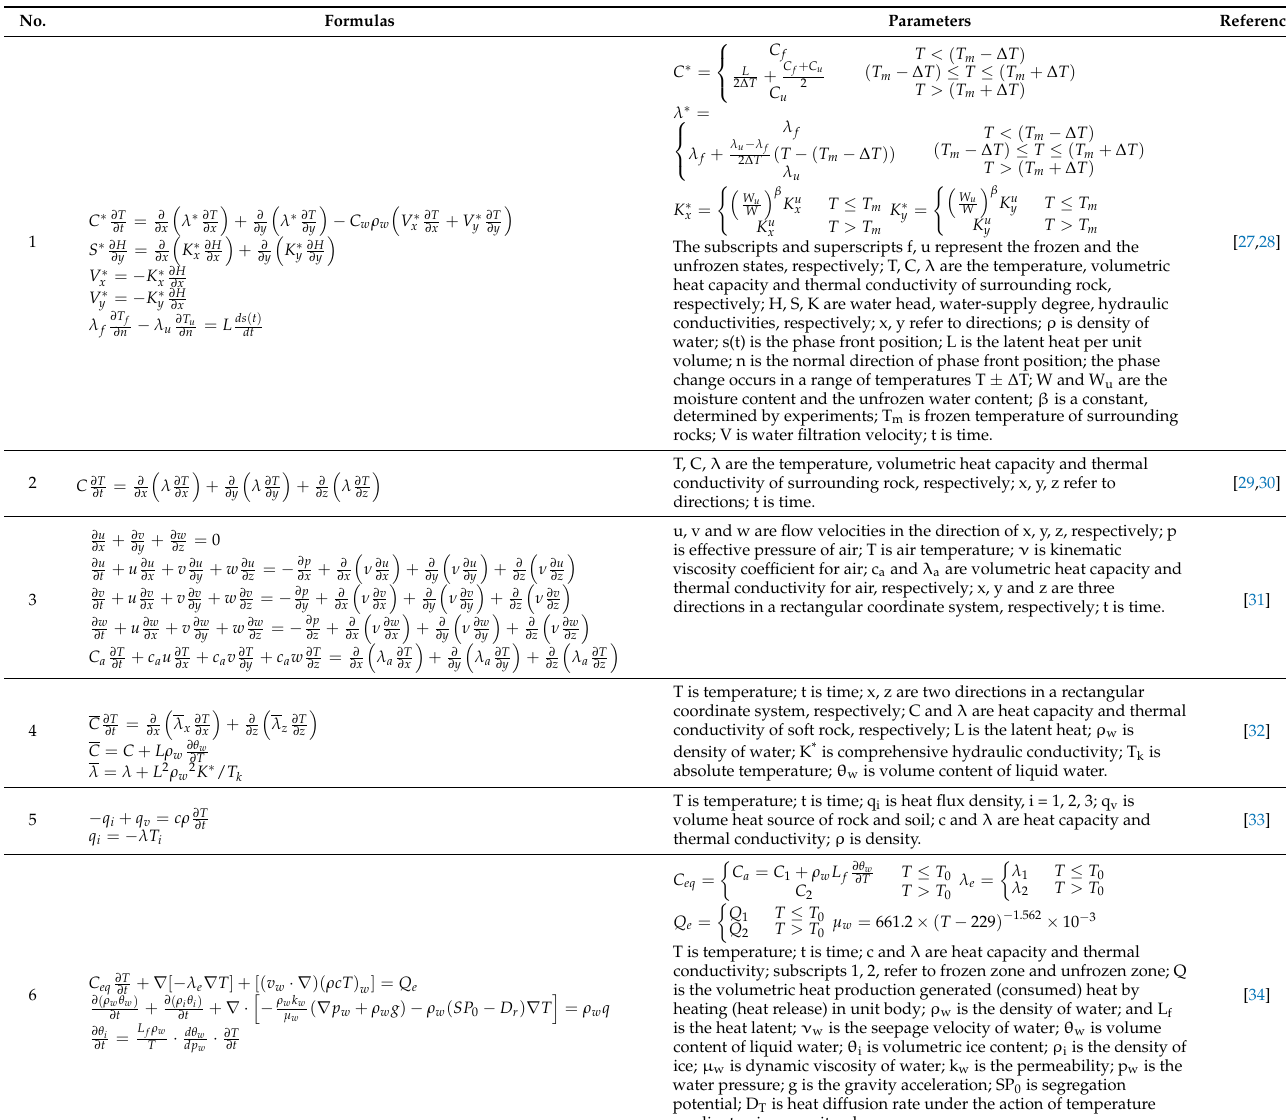
Table 2. Differential equations of the temperature